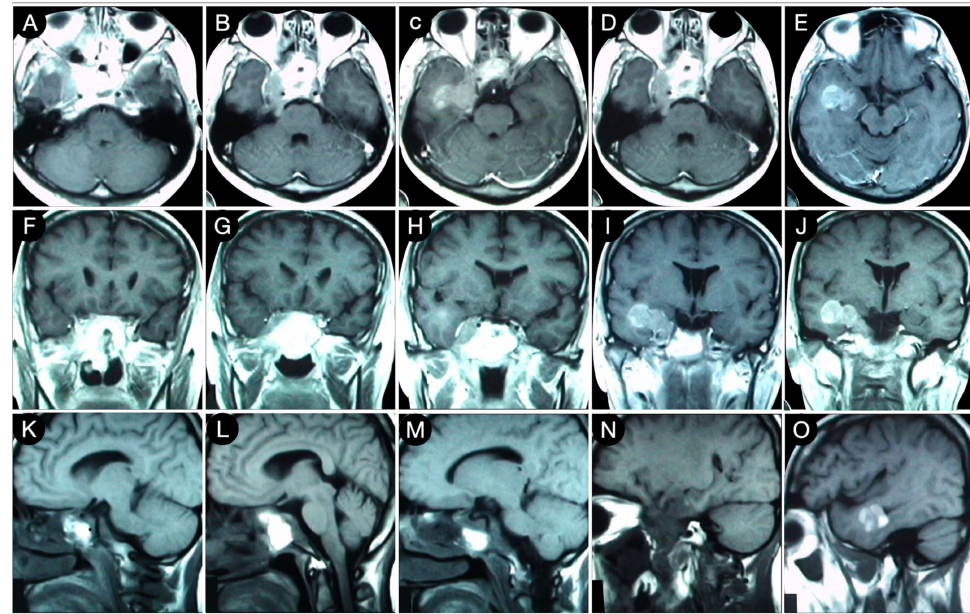
Figure 6. Axial ( A – E ), coronal ( F – J ), and sagittal ( K – O ) T1-weighted contrast-enhanced MRI after the trans-sphenoidal resection of the sellar part of the tumor. Scale bar: 5 cm. Six months later, the second stage was performed after the a new MRI scan which showed a volumetric increase in the known intracranial residue (Figure 7).